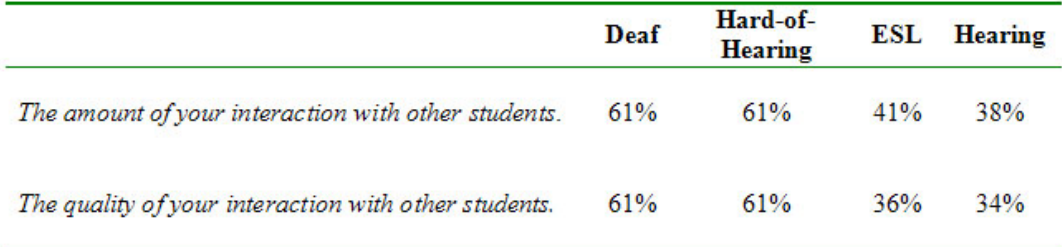
Table 2. Amount and Quality of Increased Interaction with